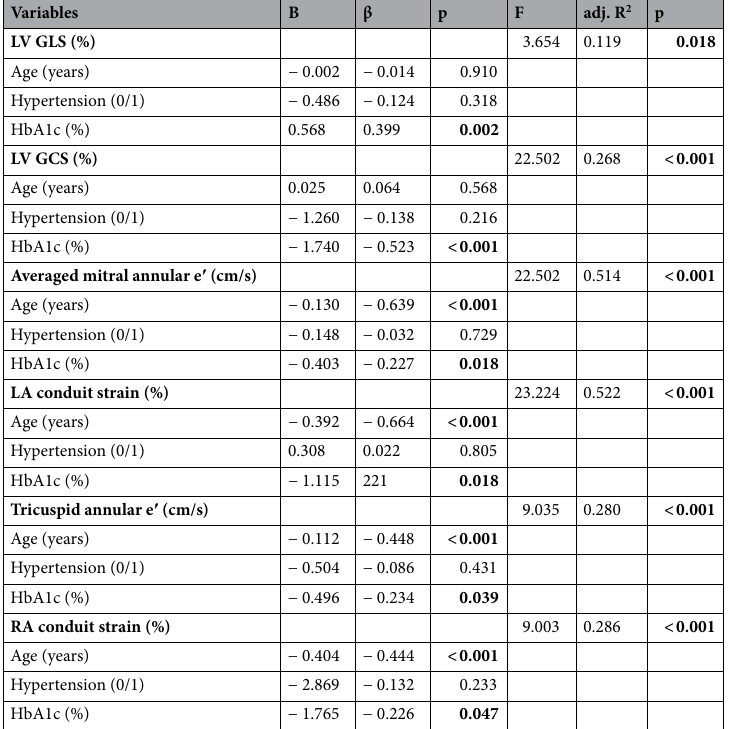
Table 3. Predictors of the echocardiographic variables in T1DM population: multivariate regression analyses. Unstandardized (B) and standardized (β) regression coefficients. Statistically significant p-values (p < 0.05) are formatted in